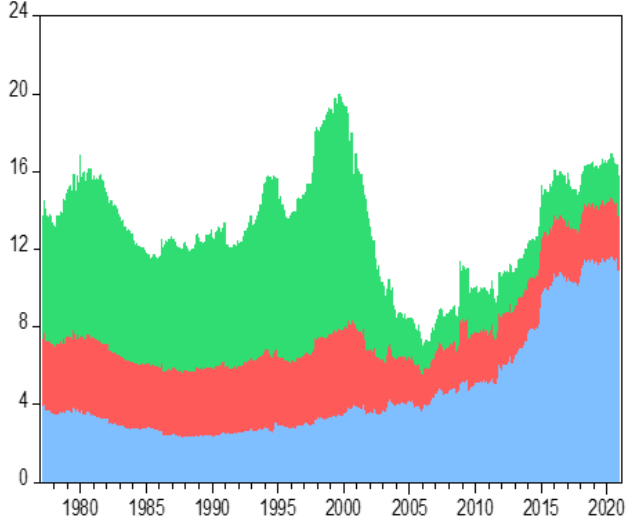
Figure 4. Inflation spillovers in the short, medium, and long term with the Barunik and Krehlik (2018) methodology. Note: The lower, middle, and upper portion of the graph represents the inflation spillover in the short, medium, and long term, respectively. J. Risk Financial Manag. 2021 , 14 , x FOR PEER REVIEW 15 of 20 Figure 5 represents the inflation spillover from other countries for each of the G7 countries for the long term. For example, the subtitle “Canda.From Freq3” represents the graph of inflation spillover in Canada from the other G7 countries for the long term. As the highest inflation spillover is observed in the long term (see Table 4), only the pictures of inflation spillover from other countries to each of the G7 countries in the long term are shown to keep the paper short and focused. All G7 countries had high inflation from the other members in around 2000 due to the high aggregate demand arising from the growth of the dotcom bubble and computer-related technology. From 2005 onwards, the inflation spillovers in each of the G7 countries from other members are stable in the long term. The adoption of the Euro in 2002 is one of the possible reasons for this incident. Although Canada, Japan, and the United States are located outside the E.U. region, the inflation spillover in each of these countries reduced in the same period because of the theory of purchasing power parity (PPP) (see Zhou et al. (2008)).